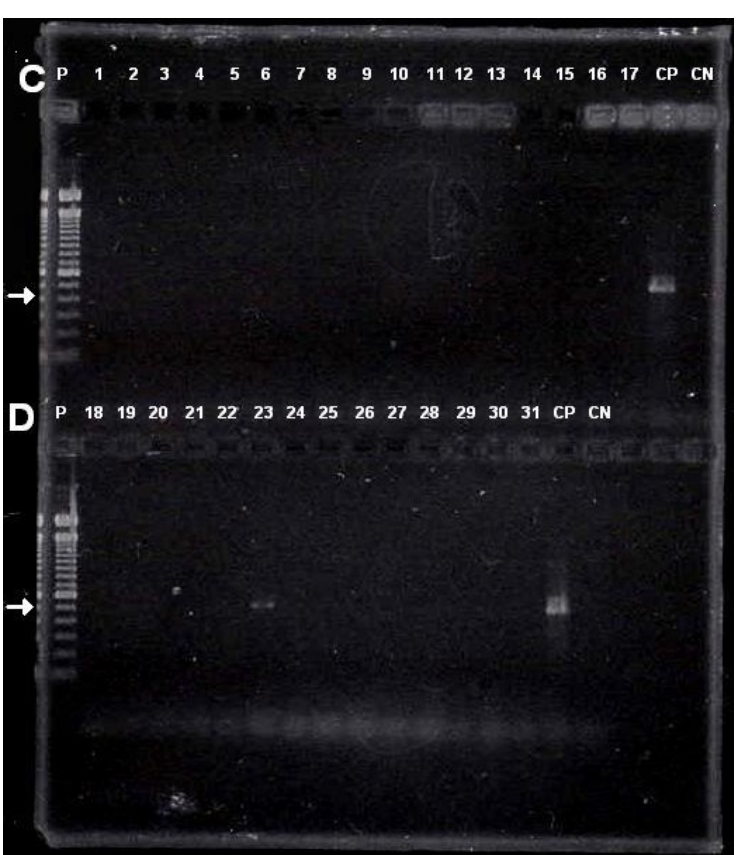
Figure 2: Polymerase chain reaction (PCR) to detect Toxoplasma gondii DNA in G1, G3 and G4 sera samples. Botucatu, 2005. C - Lanes: P - 100bp DNA-Ladder (Gibco ® ), molecular weight marker; 1, 2 and 3 - G1 samples 18h PI; 4 - G4 sample 18h PI; 5, 6 and 7 - G1 samples 24h PI; 8 - G4 sample 24h PI; 9, 10 and 11 - G1 samples 48h PI; 12 - G4 sample 48h PI; 13 -